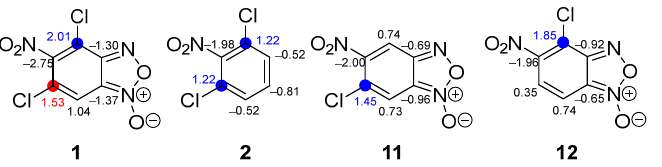
Figure 14. Mulliken partial charges of compounds 1 , 2 , 11 , and 12 . Indicated in blue are the most positive electrophilic carbon atoms; in red are the second most positive electrophilic carbon atoms.